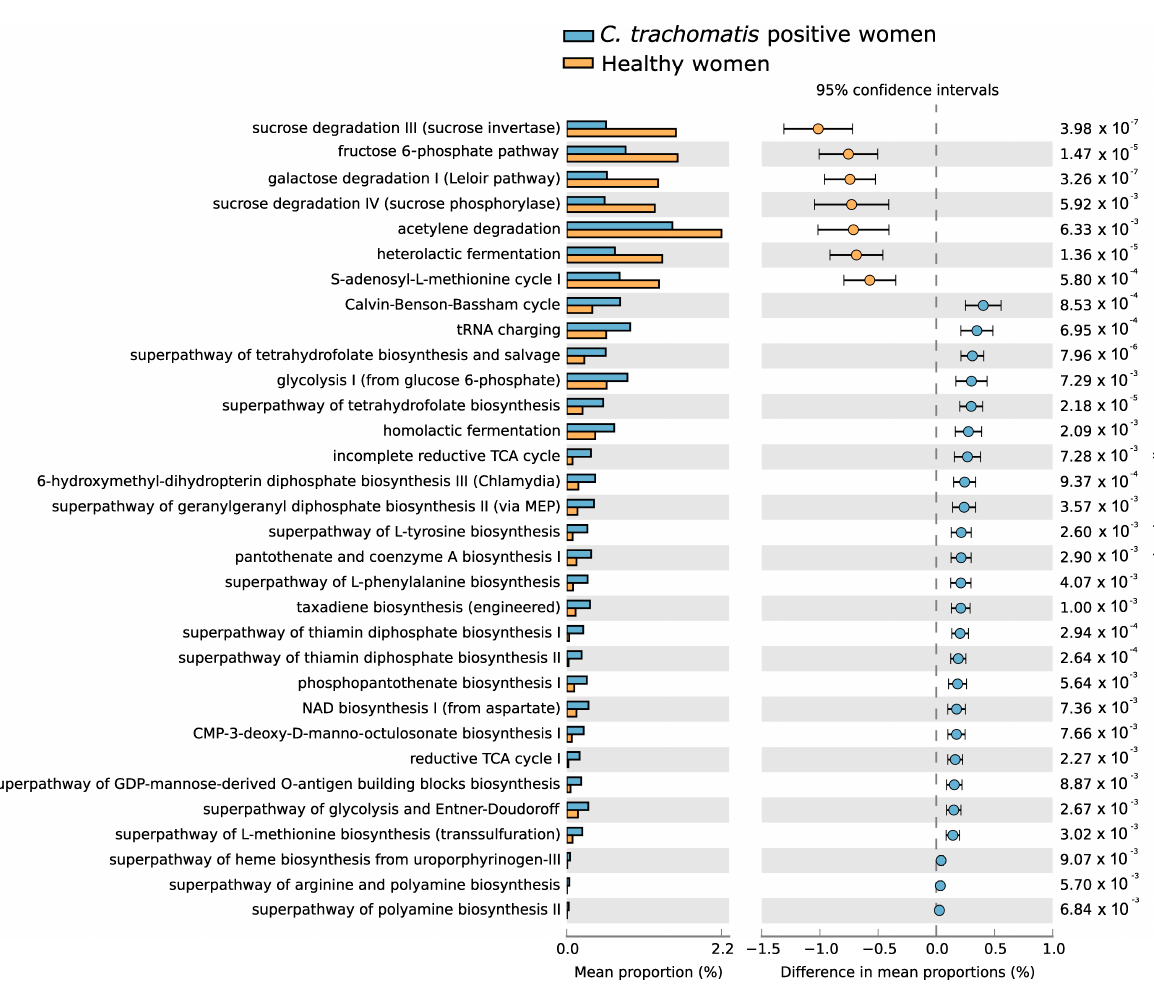
Figure 4. Differences in the composition of predicted metabolic pathways of the cervicovaginal microbiota between C. trachomatis -positive women and healthy controls. The relative abundance of each pathway was expressed as means ± standard deviations (SD), and statistical significance was calculated by Welch’s t -test.